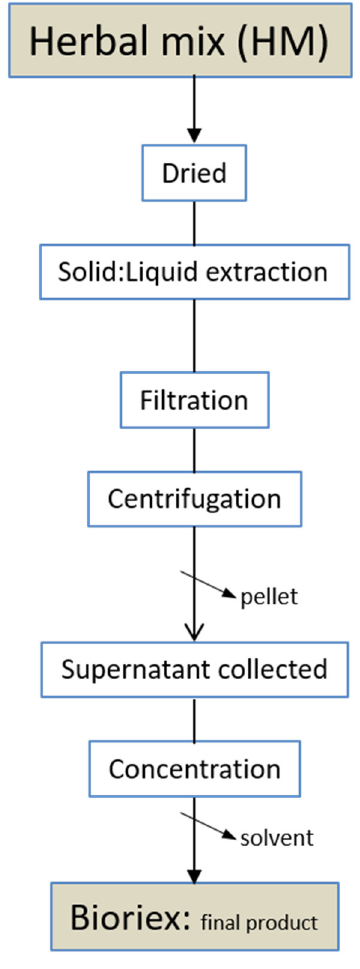
Figure 1. Scheme of the protocol used to obtain phytomelatonin-rich extracts (Bioriex) from herbal mixed selected plants (HM).